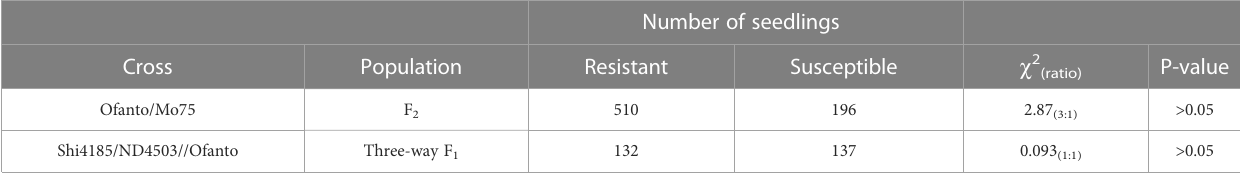
TABLE 1 Segregation of leaf rust resistance in the F 2 populations from Ofanto/Mo75 and three-way population Shi4185/ND4503//Ofanto crosses.